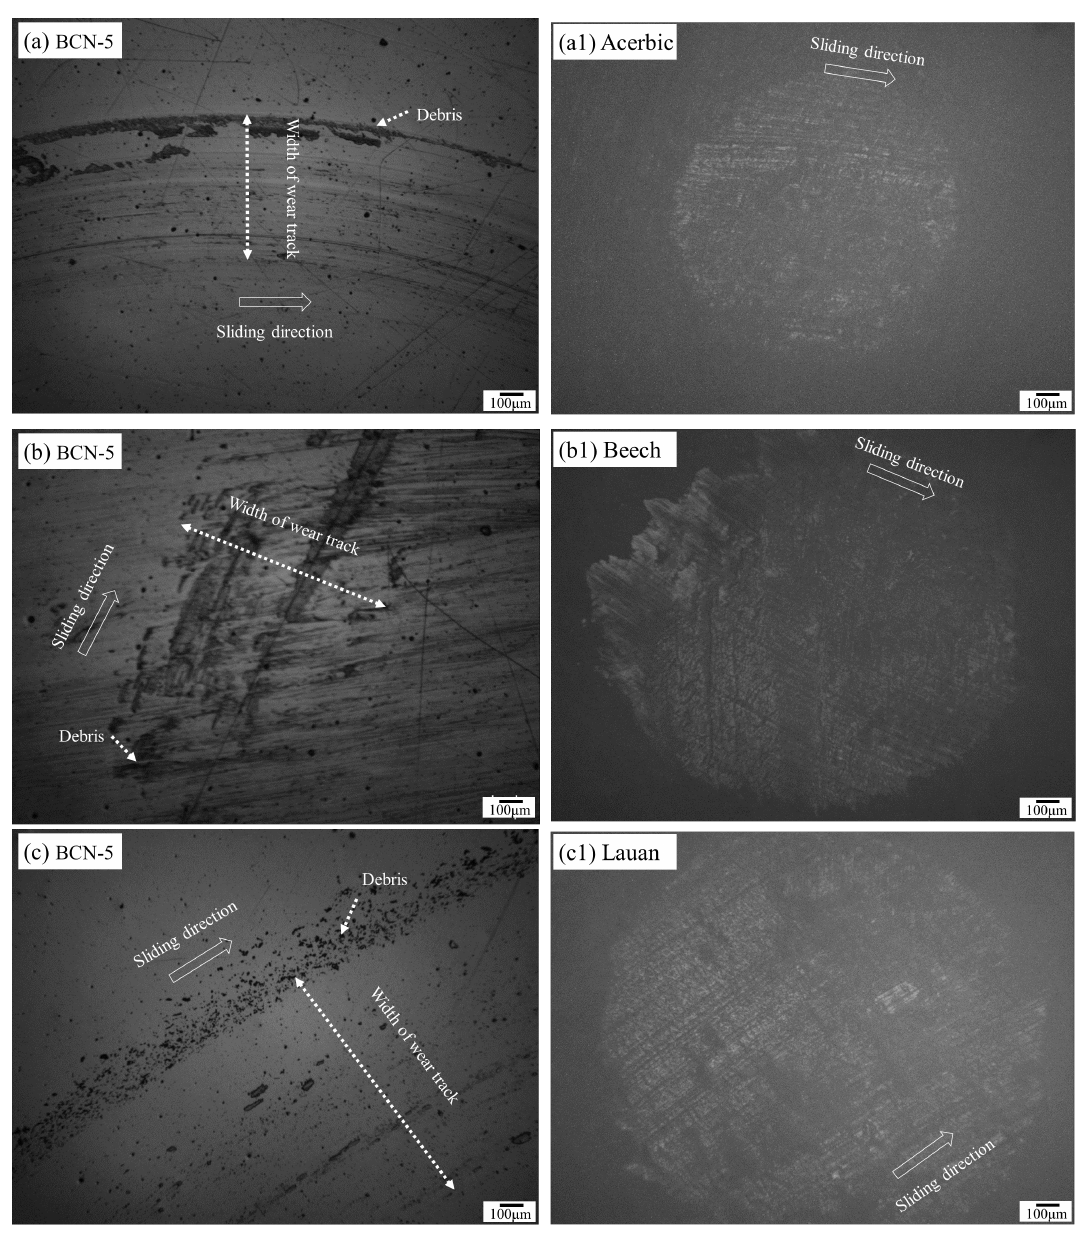
Figure 6: Optical images of wear scars for BCN-5 coating sliding against different wood